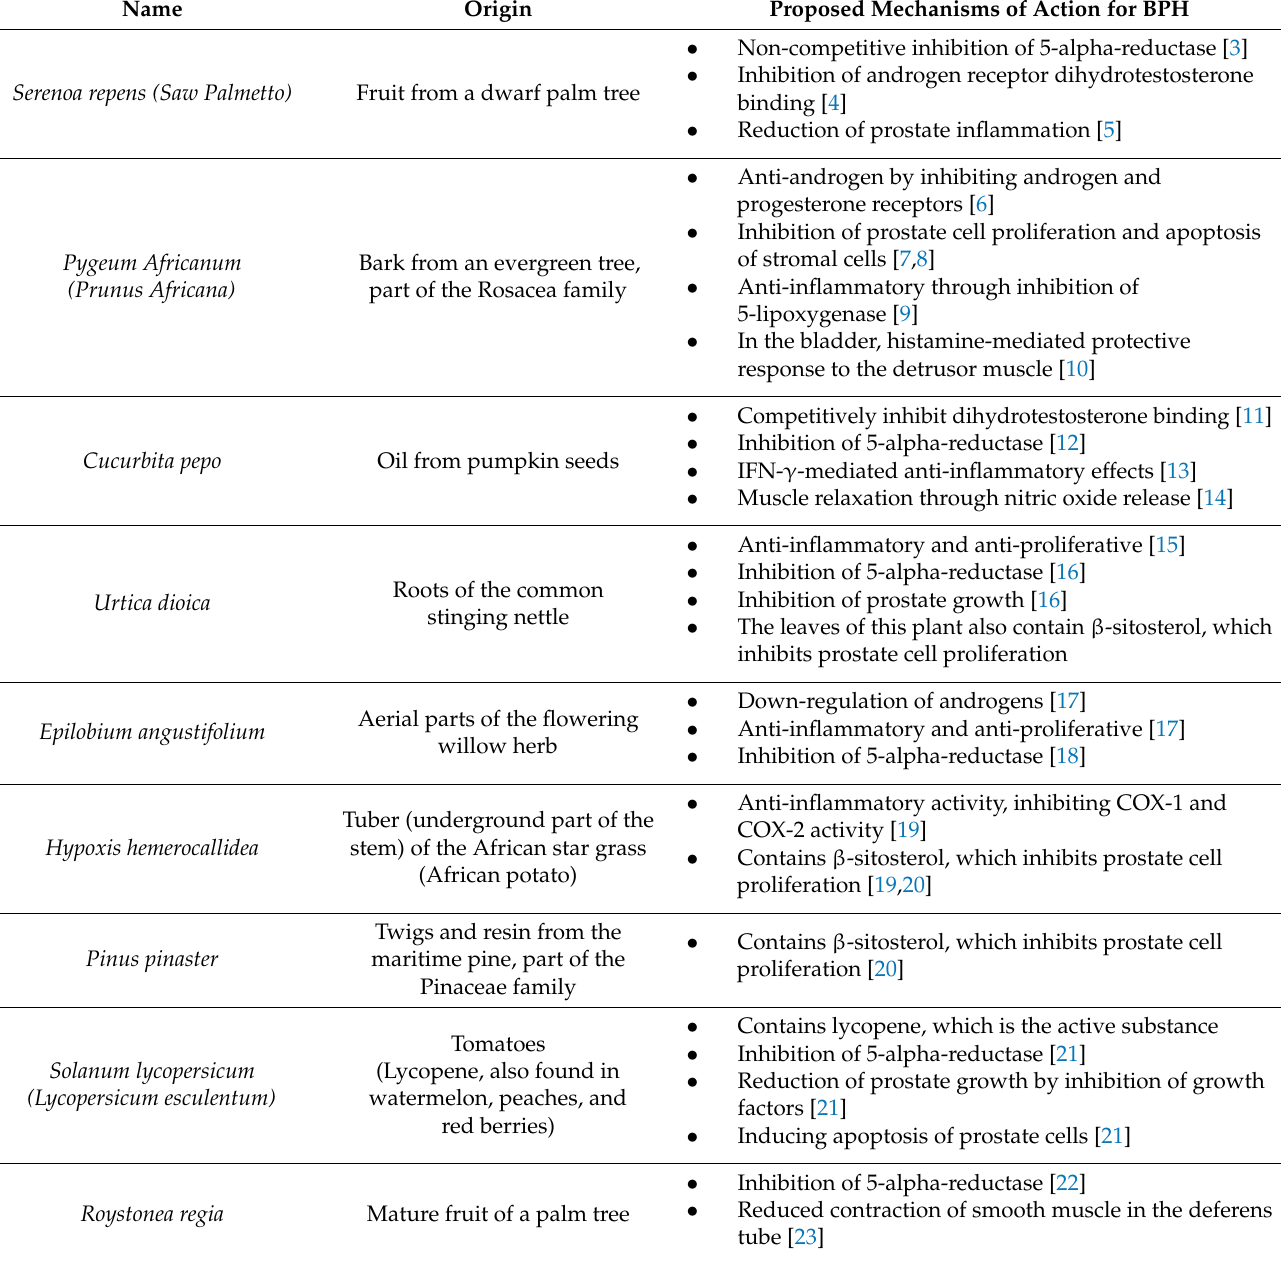
Table 1. Provides an abbreviated summary of phytotherapies for